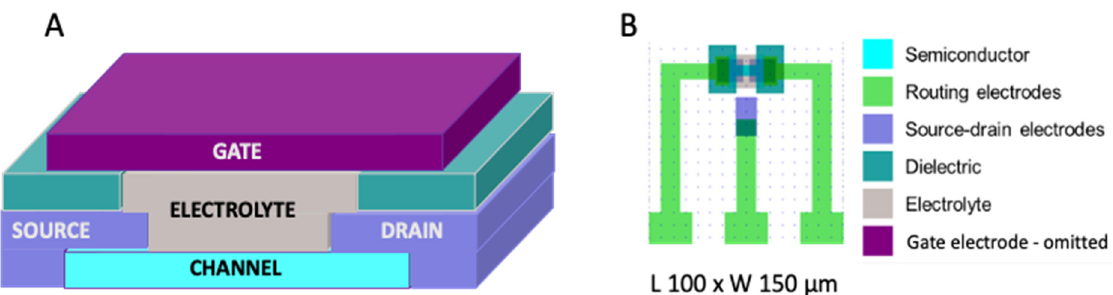
Figure 1. The specific architecture of OECT devices developed in the WEARPLEX project shown ( A ) in the cross-section and ( B ) from a top view with printing layers. The gate layer has been omitted to reveal the areas of interest.